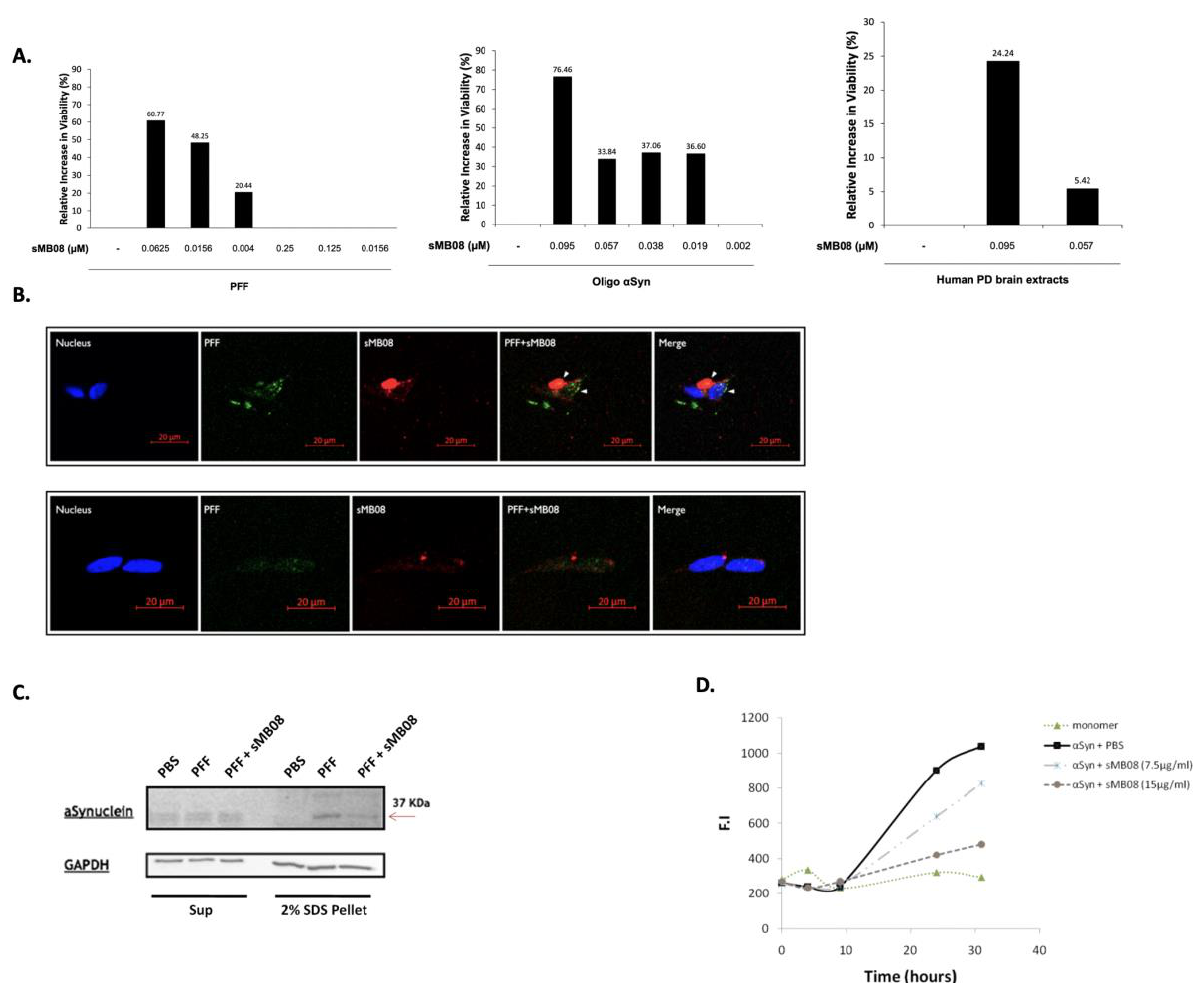
Figure 2. sMB08 penetrates neurons and attenuates aggregation and spreading of α Syn. ( A ) Bar graphs showing neuronal increase in viability mediated by sMB08 (scFv). sMB08 protects neuronal SH-SY5Y cells from α Syn PFF (left), oligomers (middle), and human PD patient brain extracts (right) mediated toxicity. The y -axis represents the relative increase in cell viability compared to PFF/oligomers/human PD brain extracts with no treatment (PBS), sMB08 treatment, and 80R scFv isotype treatment (sham); ( B ) sMB08 penetration to human neuronal cells. Confocal images of intracellular co-staining of α Syn PFF conjugated to Alexa 488 (green) and sMB08 conjugated to Cy5 (red). DAPI was used for nuclear staining in cells (blue). Scale bar is 20 µ m; ( C ) Western blot following sequential extraction of neurons in 1% ( v / v ) TX-100 followed by SDS. Immunoblotting was performed using rabbit anti-rodent α Syn, an antibody that recognizes endogenous total α Syn (upper panel) and mouse anti-GAPDH (lower panel). In PFF-treated neurons, there was an increase in SDS-soluble α Syn (2% SDS) compared to PBS or PFF+sMB08 treated neurons (red arrow); ( D ) Kinetics for the formation of β -sheet-rich assemblies: human α Syn incubated with sMB08 (7.5 µ g/mL or 15 µ g/mL) versus PBS (black solid line). Monomers (dotted line marked with triangles) were measured as base- line.